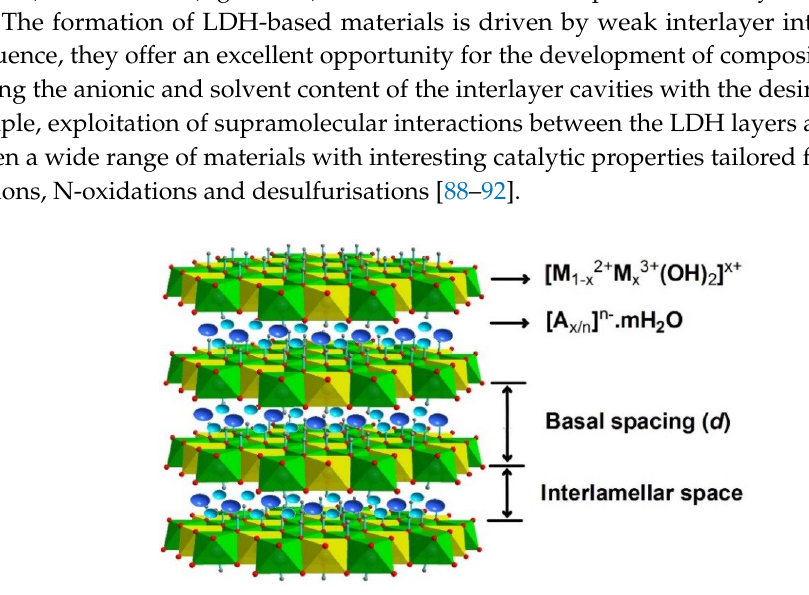
Figure 16. Schematic representation of the classical LDHs structure [88]. Adapted from Catalysts 2017 , 7, 260.